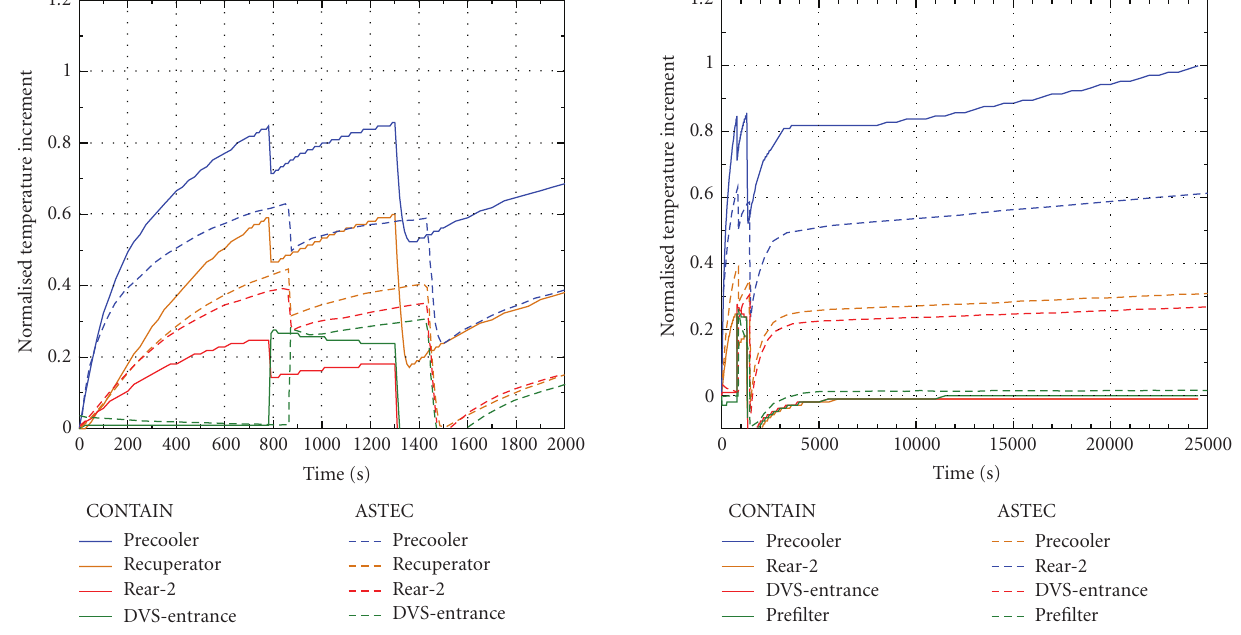
Figure 9: Temperature evolution in the main confinement com- partments for the SB sequence (short term simulation).